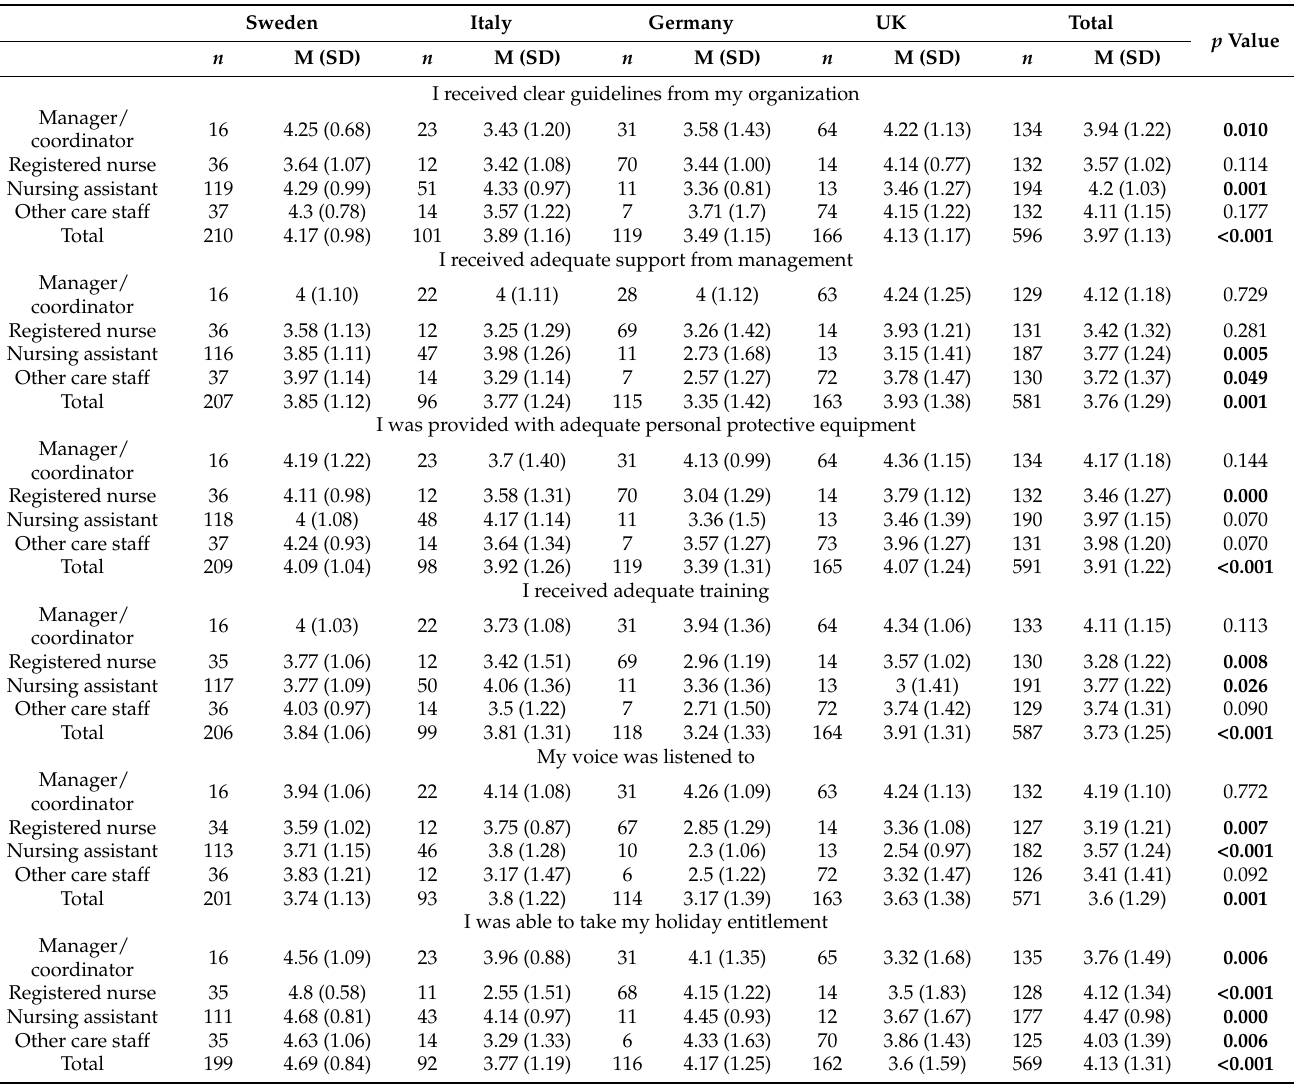
Table 3. Internal support from organization by profession and